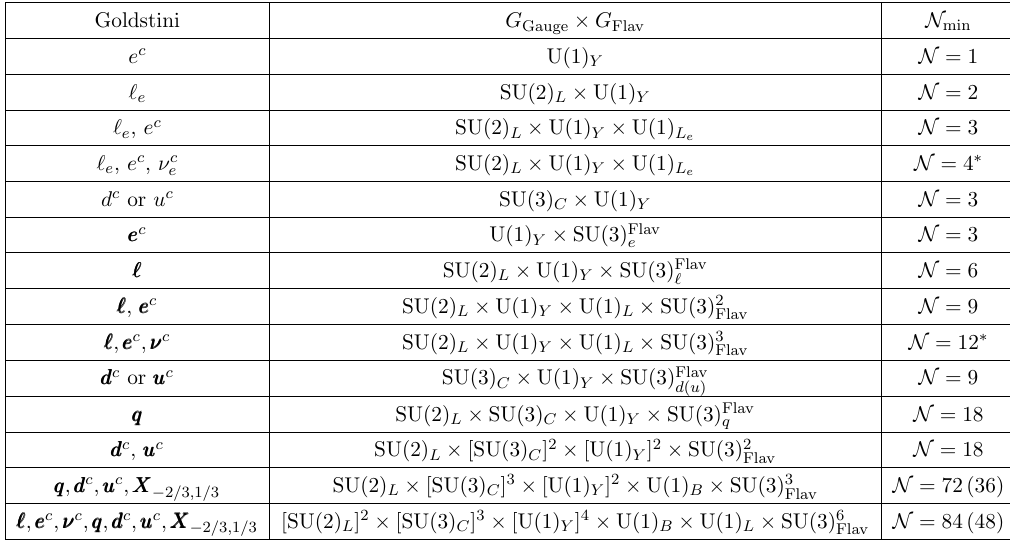
Table 3 . The minimal supersymmetry N min needed to reproduce the correct quantum numbers of SM (cid:12)elds under gauge and (cid:13)avor symmetries G Gauge (cid:2) G Flav , including the baryon and lepton numbers U(1) B and U(1) L . Boldface characters denote (cid:13)avor triplets. The notation [SU( m ) C;L;Y ] n means there are n SU( m ) factors of which only one linear combination corresponds to the gauged SU( m ) C;L;Y group. The asterisk (cid:3) marks whether SU( N ) R , as opposed to U( N ) R , is required. The number of supercharges inside parenthesis refers to N min for non-maximally R -symmetries (with Goldstini not in the fundamental